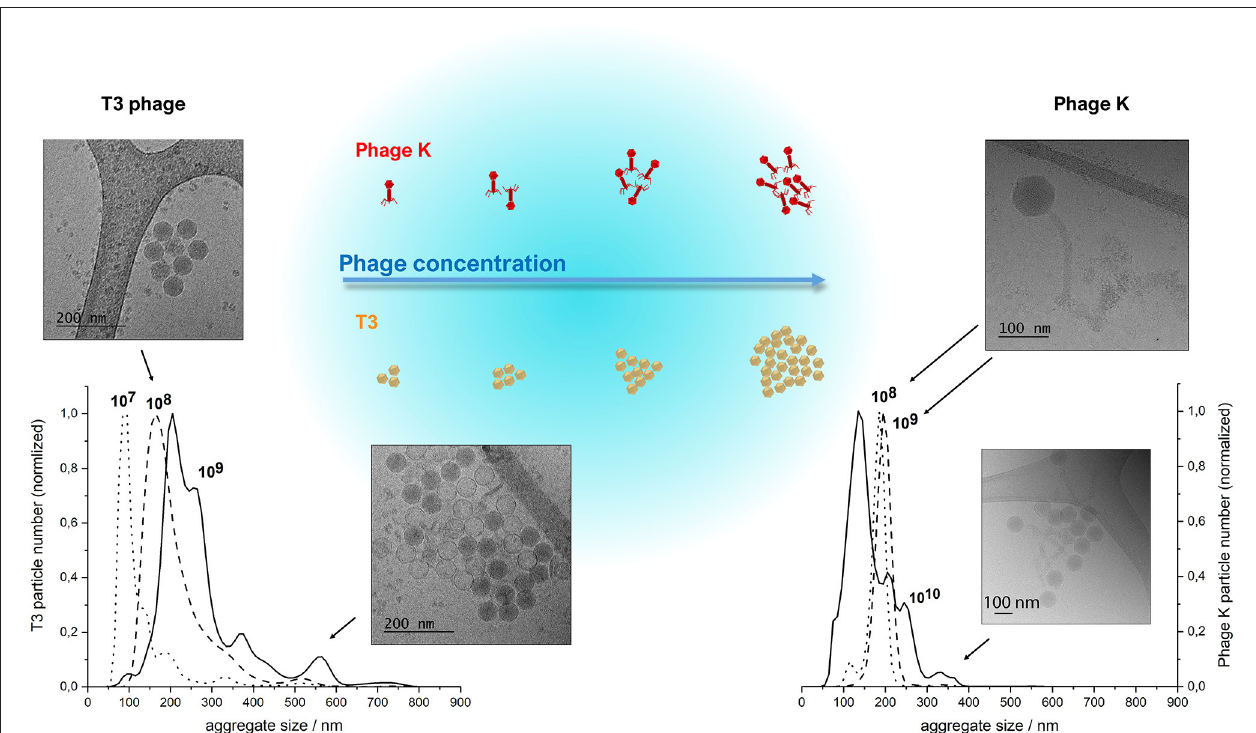
FIGURE 3 | NanoSight NTA measurements of size distributions of purified T3 phage (left) and phage K (right), respectively, at 10 7 , 10 8 , 10 9 and 10 8 , 10 9 , 10 10 PFU/ml . Insets show CryoTEM images of observed phage aggregates and the schematized depiction of phage cluster sizes as a function of phage titer. Some heads on the lower CryoTEM images are transparent (empty), probably due to denaturation of DNA during encapsulation or loss of DNA during CryoTEM imaging.